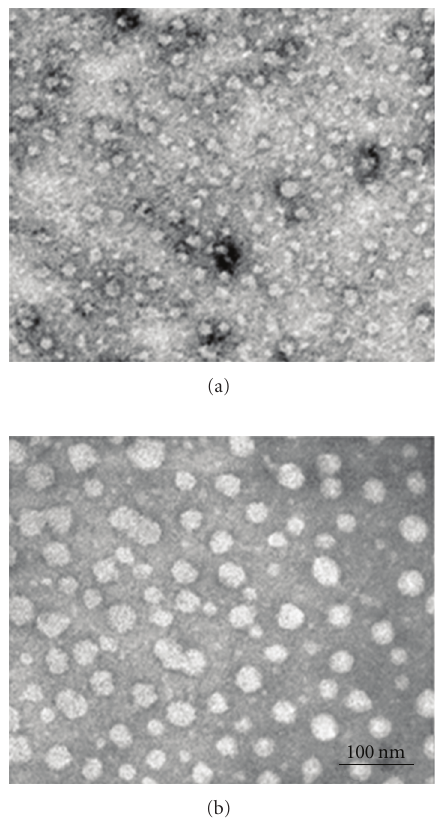
Figure 1: Negative staining electron microscopy (EM). Negatively stained CRLPw/o (b) and CRLP+ (a). The particle diameter expressed as mean ± SD was 34 ± 5 nm for CRLPw/o (190 particles) and 24 ± 7 nm for CRLP+ (160